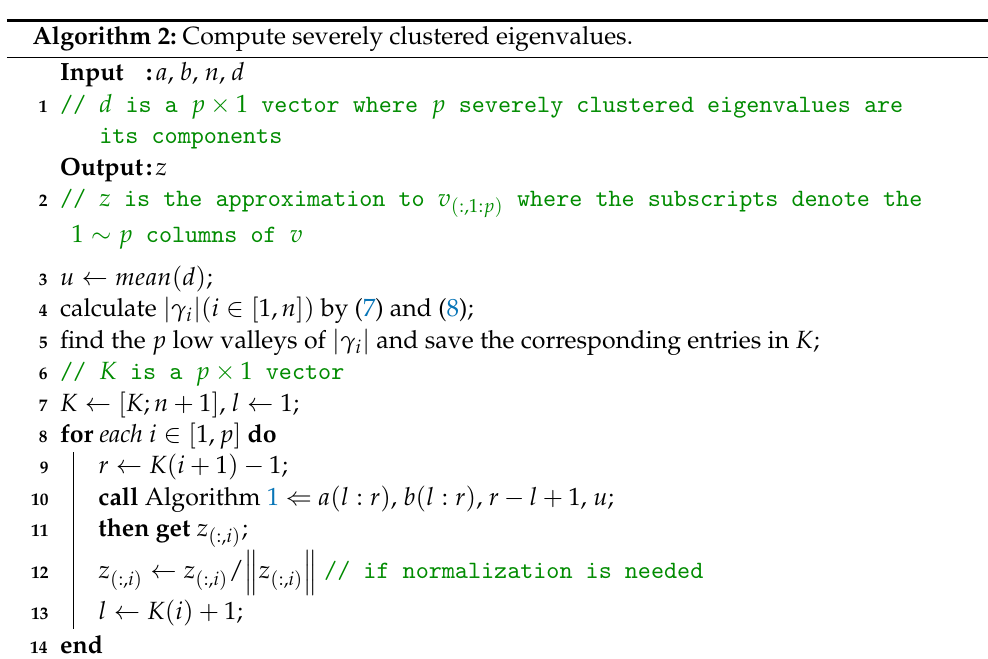
Algorithm 2: Compute severely clustered